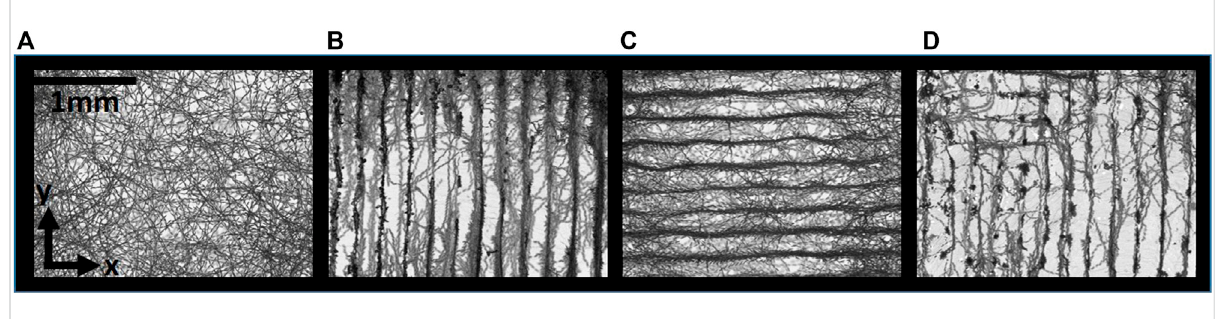
FIGURE 3 Mode pattern visualization by means of the actively swimming micro-organisms Euglena gracilis under acoustic trapping from (A) top- transducer, (B) top-andx-transducer, (C) top-andy-transducer, (D) allthreetransducers.Theimagesareaminimum-intensityprojectionofavideo recording from the center region of the trapping